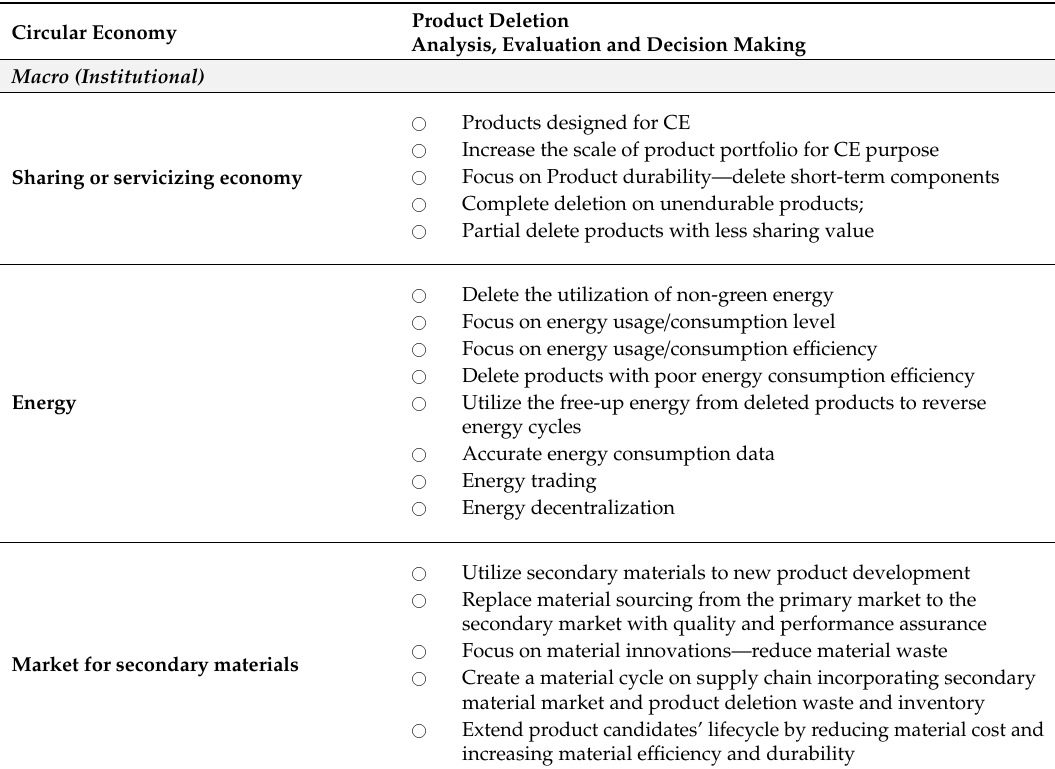
Table 1. At the nexus of blockchain technology, the circular economy, and product deletion. Circular